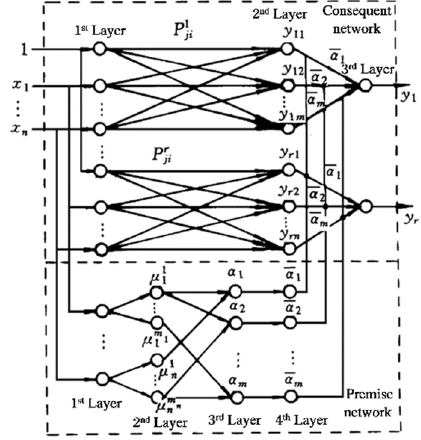
Figure 8. Fuzzy neural network structure diagram of T-S model.